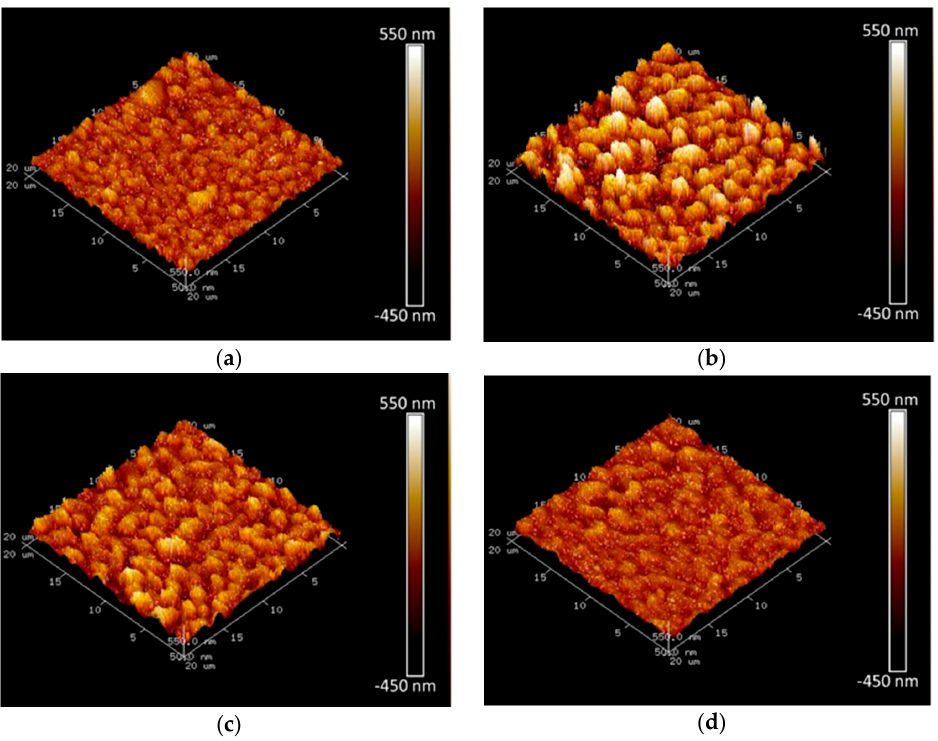
Figure 6. AFM photo when the applied voltage was ( a ) 180, ( b ) 220, ( c ) 260, and ( d ) 300 V, for the fixed electrode distance of 20 mm and cathodic specimen speed of 0.25 mm/s.